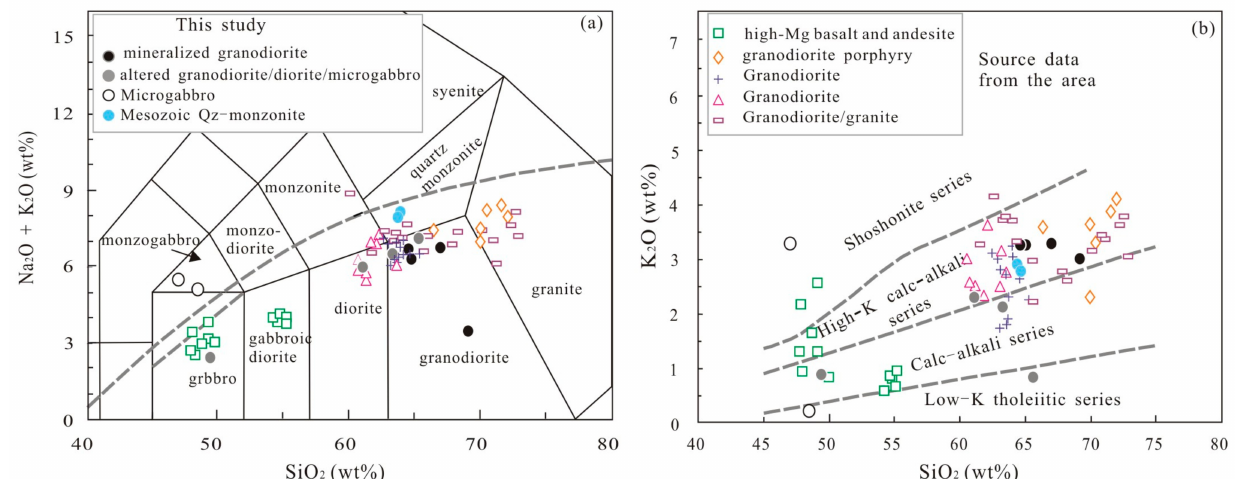
Figure 4. Plots of ( a ) SiO 2 versus (K 2 O + Na 2 O) (after [65]) and ( b ) K 2 O versus SiO 2 (after [67]) for the early Paleozoic igneous rocks in the DBS-TS porphyry Cu-Mo deposit. Circles with different colors in Figure 4b are the same as in ( a ). Data sources for ( b ): high-Mg basalt and andesite (green open square) from [26], granodiorite porphyry (brown diamond) from [24], granodiorite (blue cross) from [13], granodiorite (pink triangle) from [28], and granodiorite/granite (purple rectangle) from